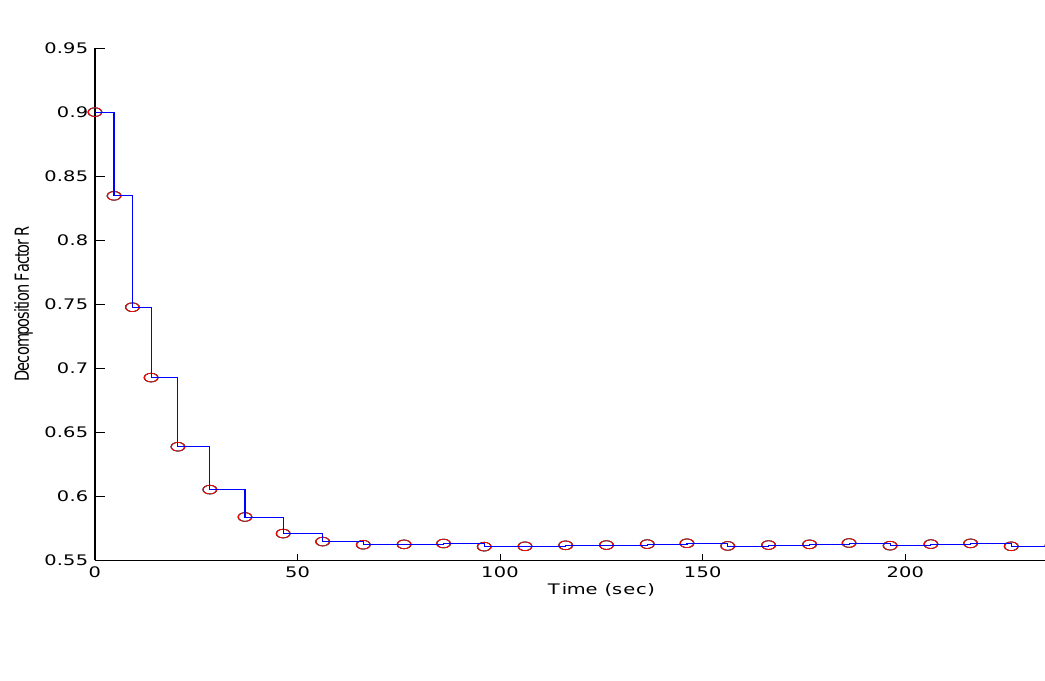
Figure 9 . Convergence Error over experimental time (Initial values R = 0 : 9 , T d = 10 s, and (cid:22) = 0 : 01